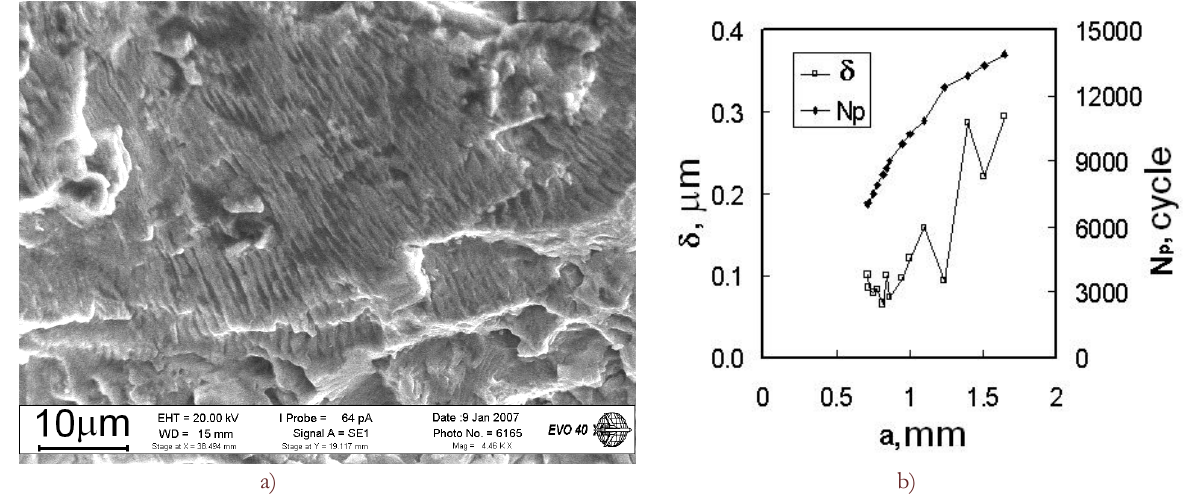
Figure 8: View of : (a) fatigue striations in fracture surface of one of the fatigued specimens; (b) typical dependence fatigue striation spacing  and number of load cycles Np on the crack length a